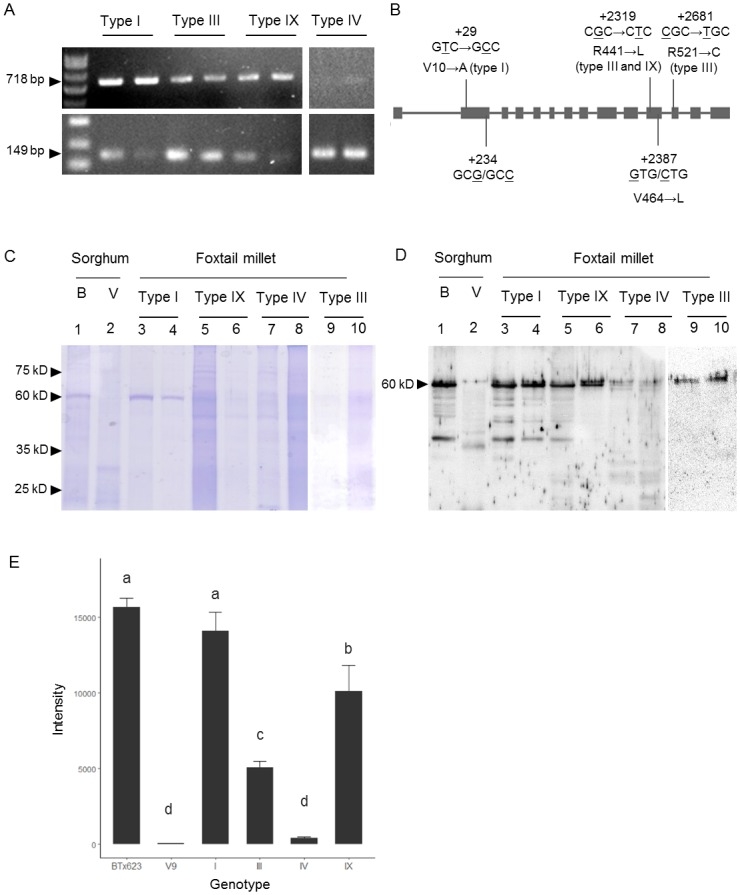
Genetic information for four Wx genotypes.(A) Transcripts of four Wx alleles in developing seeds at 10 DAF (upper panel). The housekeeping gene, EF1a, was used as internal control (lower panel). (B) SNP sites on different Wx genotypes. (C) Assay of granule-bound proteins of 2 sorghum and 8 foxtail millet accessions separated by SDS-PAGE. Lane 1: BTx623 (non-waxy sorghum); lane 2: V9 (waxy sorghum); Lanes 3 and 4: Type I (non-waxy type); lanes 5 and 6: Type IX (low AAC type); lanes 7 and 8: Type IV (waxy type); lanes 9 and 10: Type III (low AAC type). (D) Immunoblotting of GBSSI for different Wx genotypes. (E) GBSSI contents were reflected by band intensities of immunoblot quantified by ImageJ. Means with the different letter superscripts are significantly different at p<5% level, according to Fisher LSD test.